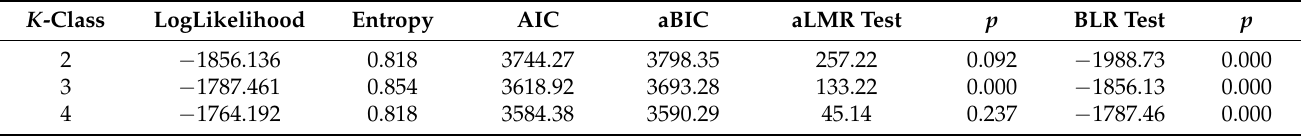
Table 3. Model fit for different solutions of k Stigma